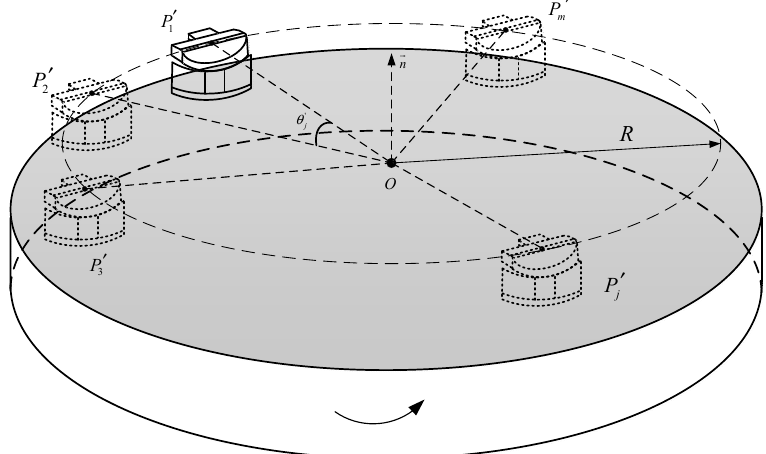
Figure 3. Schematic diagram of the relationship between the position of the laser tracer and the rotating axis.